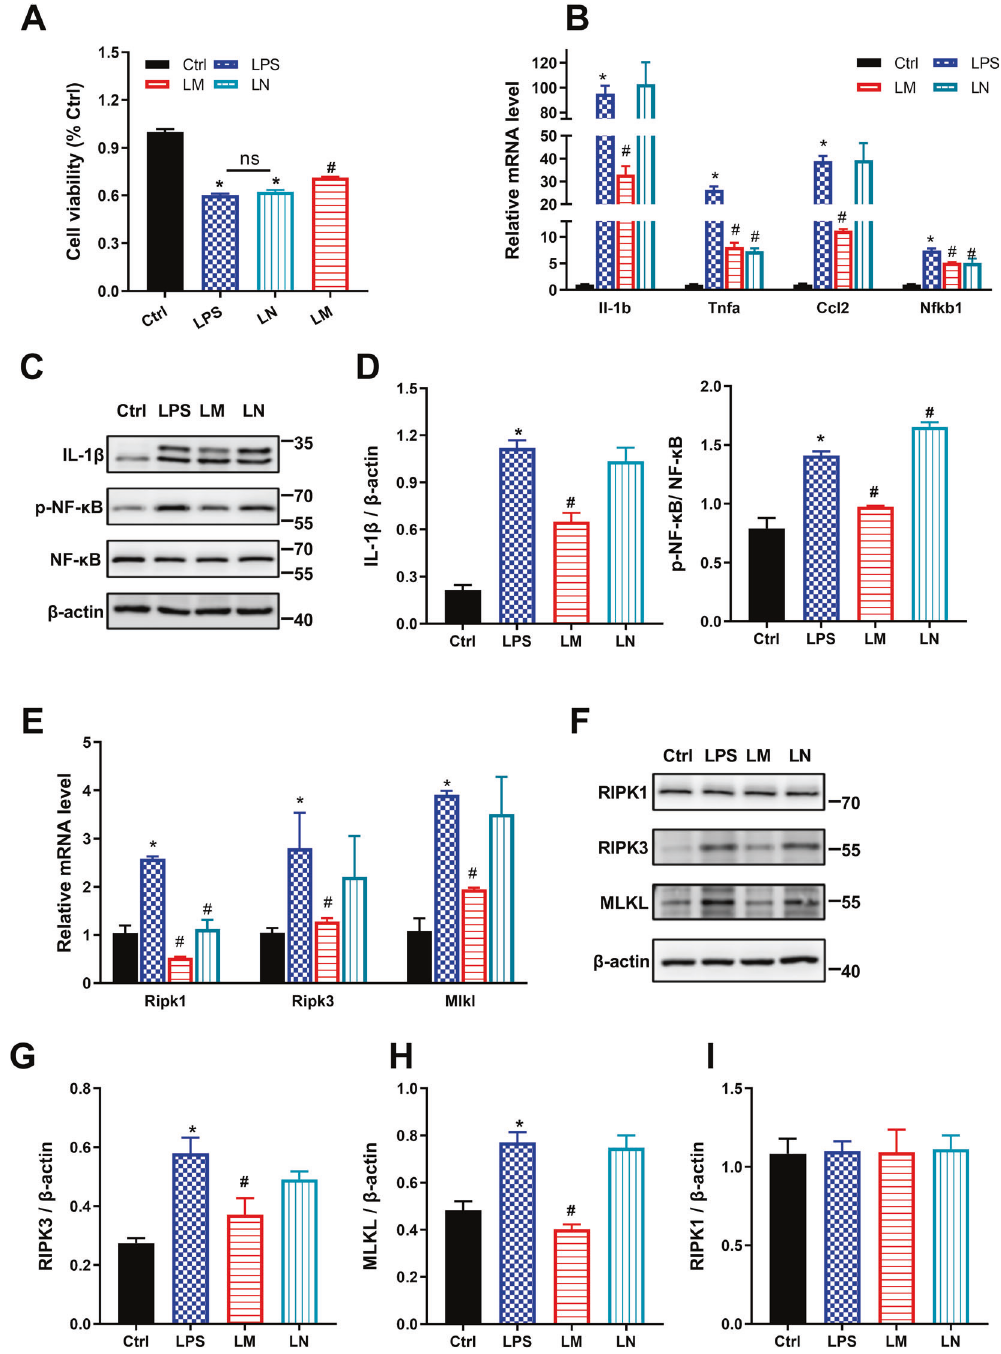
Fig. 4 Necroptosis blockade using Nec-1s shows no effect on LPS stimulation in BV2 microglial cells in vitro. Cultured BV2 microglial cells were stimulated with LPS (500 ng/ml) for 12 h before adding LPS, metformin (2.5 mM), and Nec-1s (0.5 μ M) for an additional 12 h, respectively. A Cell viability analysis showed ~40% cell death in LPS cells and ~72% cell survival in the LM group. No signi fi cant difference was evident after Nec-1s adding compared with LPS. B qPCR data showed proin fl ammatory genes were upregulated by LPS, whereas downregulated by metformin. There was no difference observed in Il-1b and Tnfa gene expression after Nec-1s treatment in BV2 cells. Nevertheless, the mRNA of Tnfa and Nfkb1 were expressed at lower levels in the LN cells. C , D Immunoblotting data showed lower expression levels of IL-1 β and NF- κ B in the LM group, indicating metformin anti-in fl ammation effects on LPS-stimulated cells. Nec-1s adding caused slightly increased NF- κ B activation but similar IL-1 β expression with that in the LPS group. E – I qPCR and immunoblotting for RIPK1, RIPK3, and MLKL. The expressions of RIPK3 and MLKL were elevated in LPS and LN but reduced in LM. RIPK1 was upregulated in LPS and downregulated by LM and LM at the mRNA level, but no difference was observed in the four groups, implying LPS-induced necroptosis in BV2 cells were RIPK1-independent. n = 3 independent cultures. The data were presented as mean ± SEM. * P < 0.05 vs. Control cells; # P < 0.05 vs. LPS-stimulated cells.